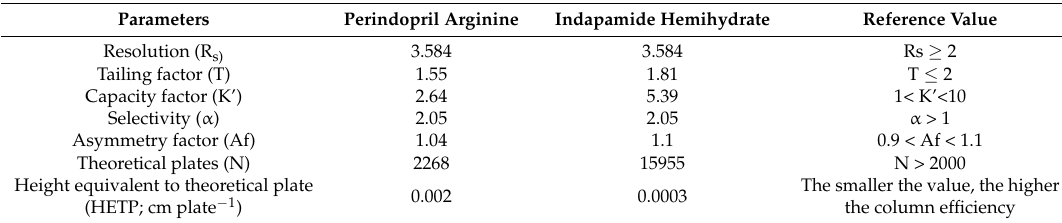
Table 1. Parameters of system suitability testing of the adopted chromatographic methods for the simultaneous determination of Perindopril arginine and Indapamide hemihydrate.